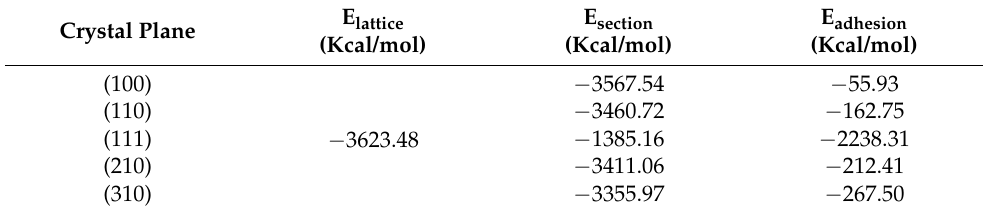
Table 1. Adhesion energy of different crystal plane of MgO. Crystal